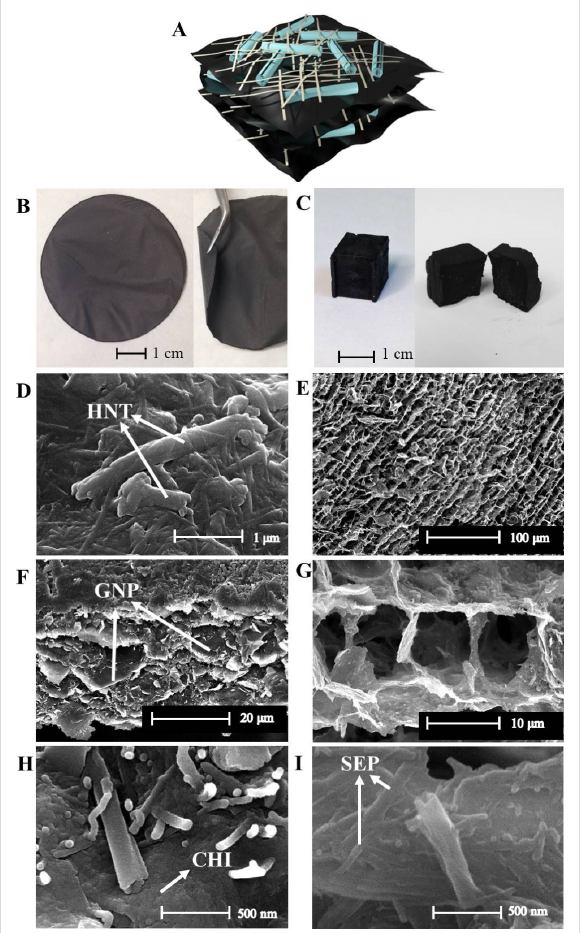
Figure 3: Schematic representation of particle assembly in the multi- component bionanocomposites: A) cross section of processed materi- als: HNTs and SEP are represented as tubes and fibres, while chitosan, GNPs and MWCNTs are depicted in the black matrix. Photographs of B) Film-1 and C) Foam-1. SEM micrographs of the film: D) upper surface, F) and H) cross section; SEM micrographs of the foam: E) and G) pore architecture, I) cell